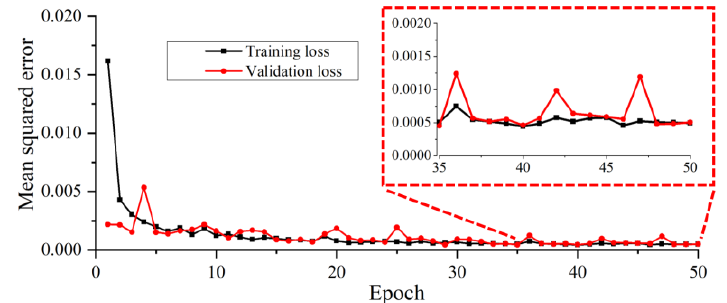
Figure 8. The training set loss curve and validation set loss curve.